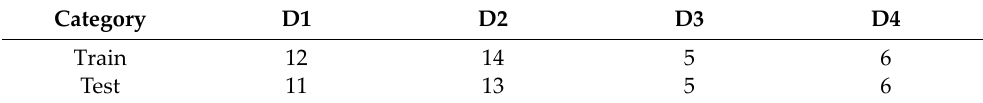
Table 3. Experimental data.